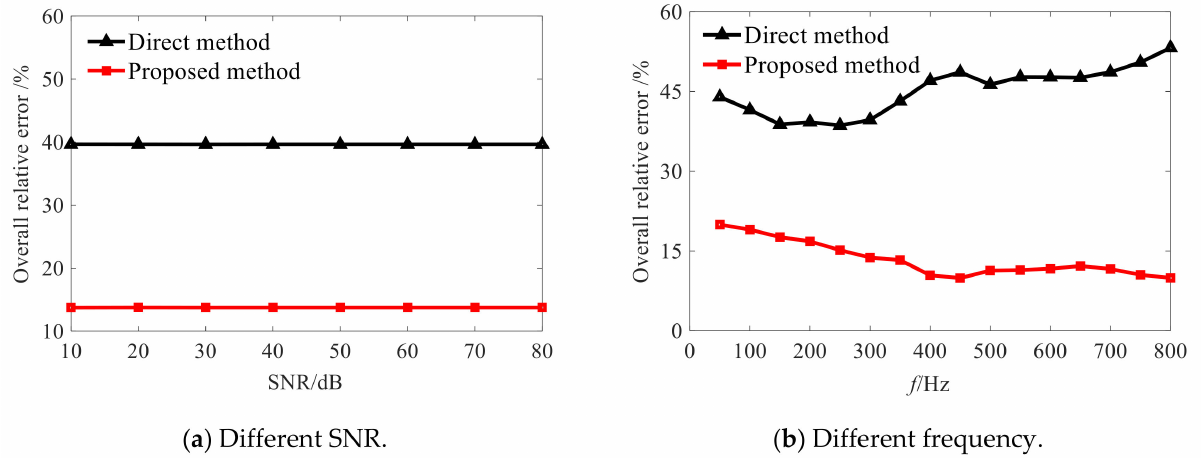
Figure 12. Overall relative errors of the two methods with 40 ◦ cone